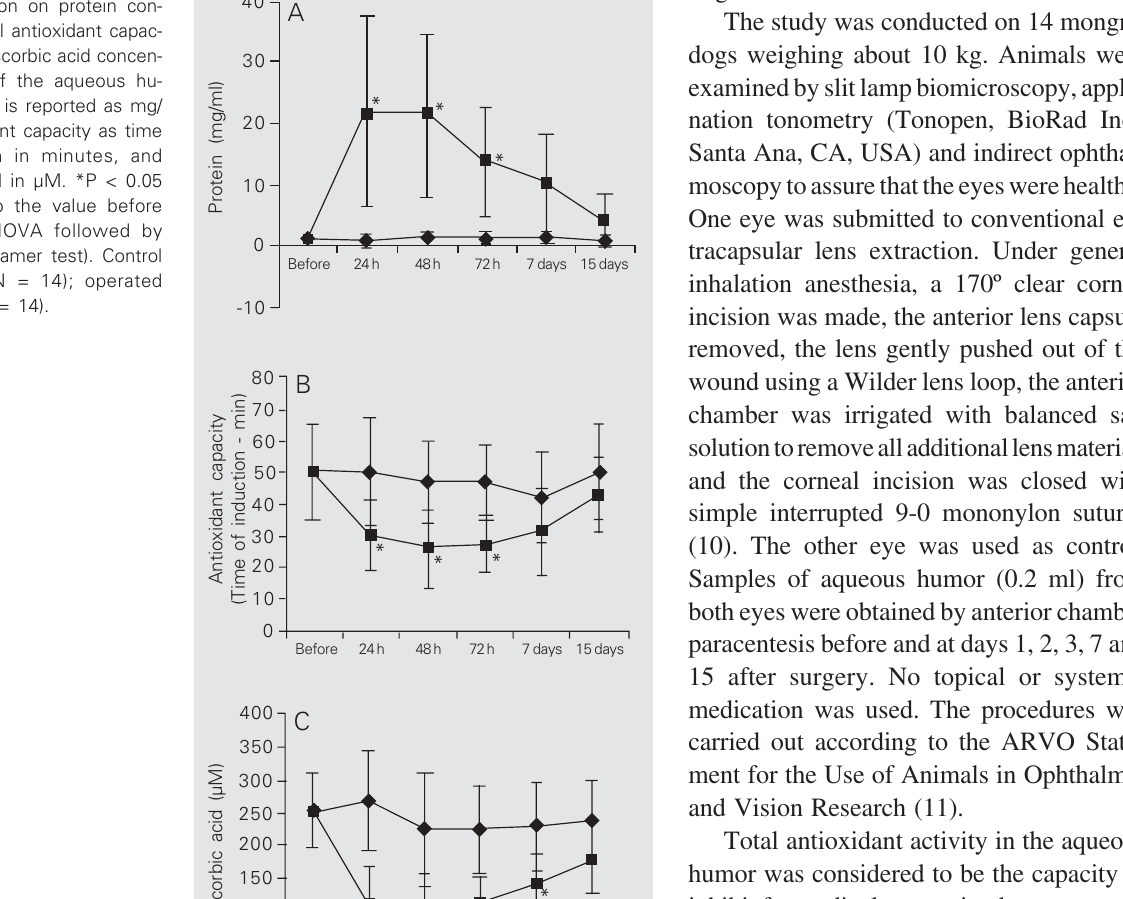
Figure 1. Effect of extracapsular lens extraction on protein con- tent (A), total antioxidant capac- ity (B) and ascorbic acid concen- tration (C) of the aqueous hu- mor. Protein is reported as mg/ ml, antioxidant capacity as time of induction in minutes, and ascorbic acid in µM. *P < 0.05 compared to the value before surgery (ANOVA followed by the Tukey-Kramer test). Control (lozenges, N = 14); operated (squares, N =